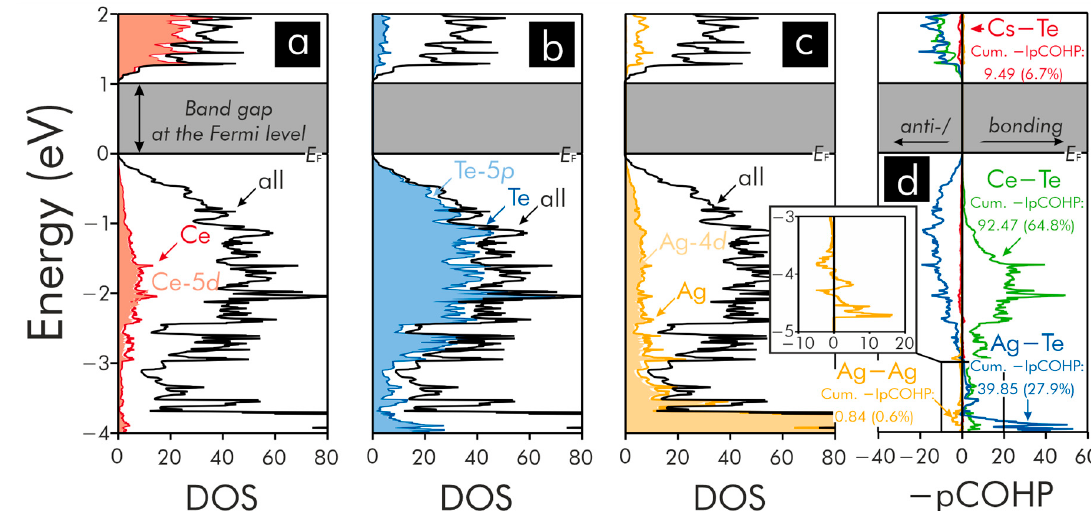
Figure 4. Densities-of-states (DOS) curves and projected crystal orbital Hamilton populations (pCOHP) of CsCe 2 Ag 3 Te 5 : the lower and upper black horizontal lines indicate the valence band maximum and conduction band minimum, respectively, while the total, atom- and orbital-projected DOS curves are shown in ( a – c ). The orbital-projected DOS curves correspond to those states providing the largest contributions to the occupied states near E F . The Ag − Ag − pCOHP are shown in the inset for a better representation ( d ).